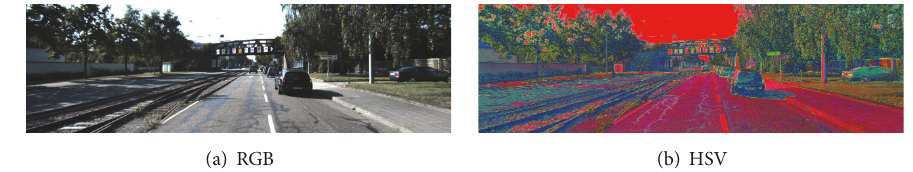
Figure 5: Two images of different colour spaces. (a) RGB and (b) HSV colour transform.